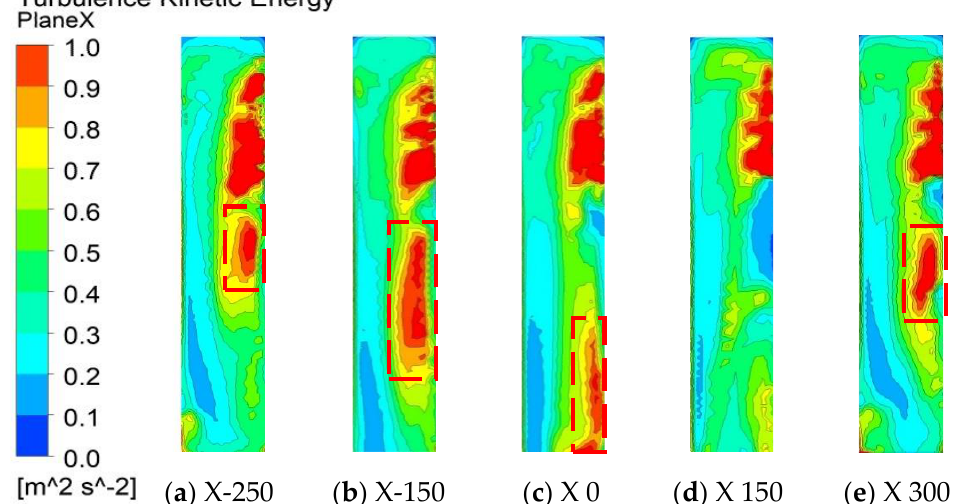
Figure 8. Turbulent kinetic energy cloud map of X-direction cross-section in the head duct of integrated stove prototype.